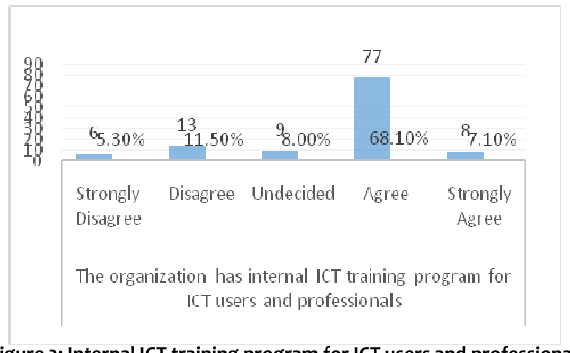
Figure 2: Internal ICT training program for ICT users and professionals Source: Author Data